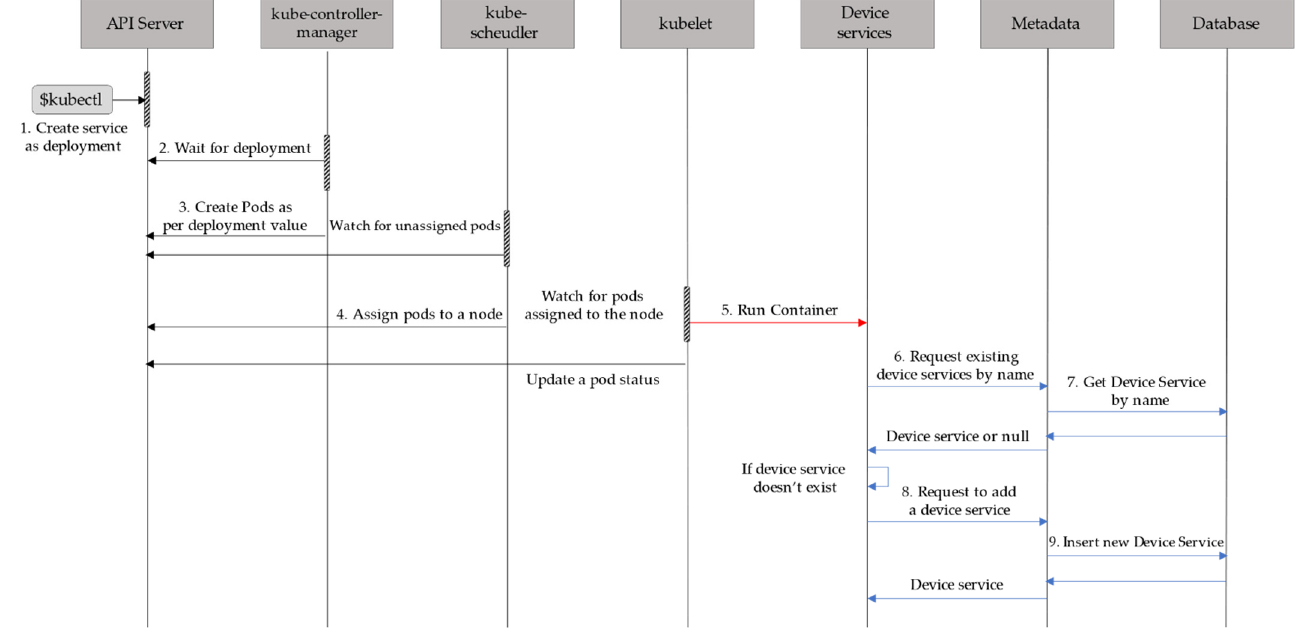
Figure 3. EdgeX over Kubernetes service deployment procedure.